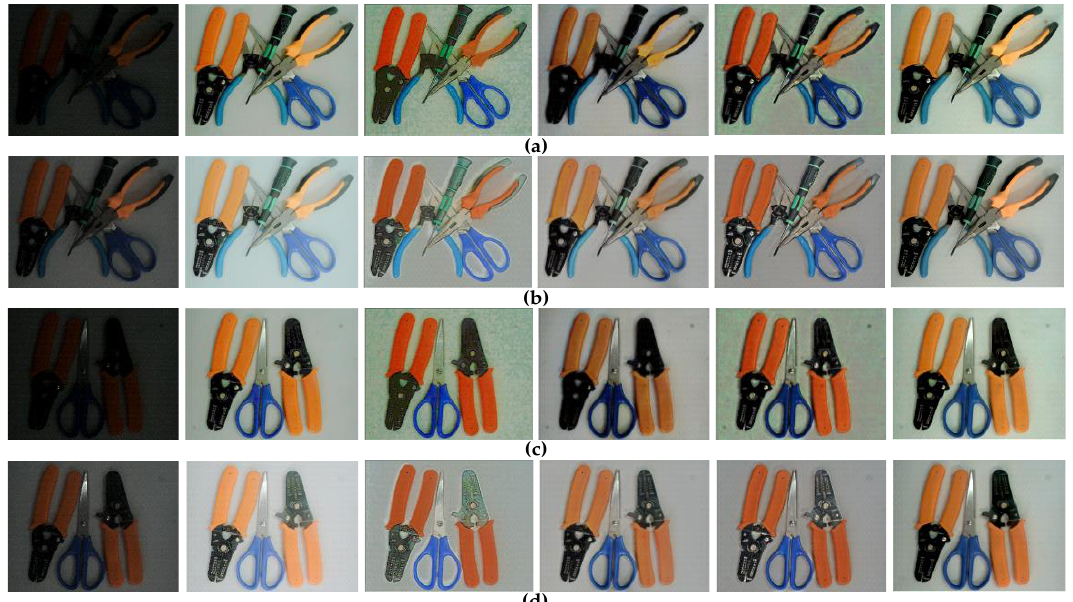
Figure 7. Low-illumination MSRCR RetinexNet KinD MBLLEN Ours.Comparison of the processing effects on the special datasets: ( a , b ) pictures of the same tool under different lighting conditions and ( c , d ) pictures of the same tool under different lighting conditions.